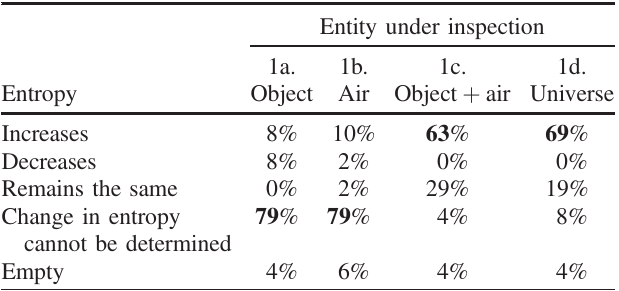
TABLE I. Percentages of students ’ categorized responses related to the items addressing the macroscopic nature of the second law and changes in entropy in a heat transfer process. The percentage of correct responses is featured in boldface N ¼ 48